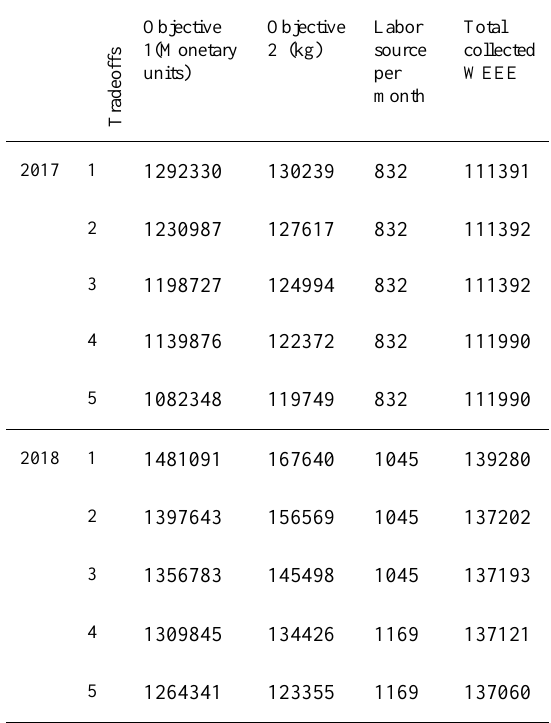
Table 6. Trade off table of 2017 and 2018 for unit-based target.